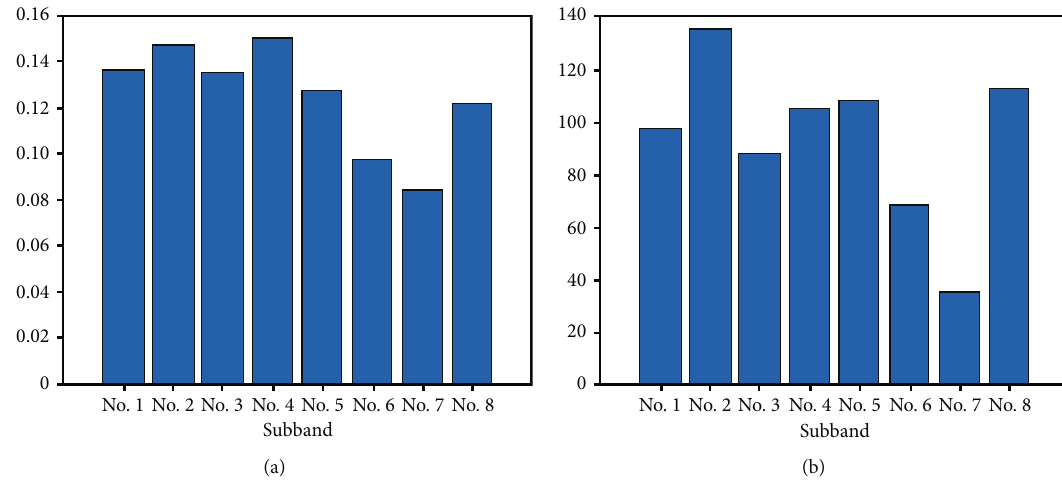
Figure 17: Wavelet decomposition subband energy ratio (a) and wavelet feature-scale entropy (b) of broken layer